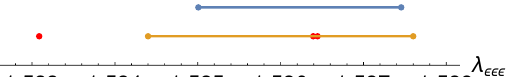
Figure 2 . In blue: rigorous bounds on λ (cid:15)(cid:15)(cid:15) 0 found at Λ = 19 using algorithm 2. In or- ange: the interval corresponding to one standard deviations of the values found for λ ing the extremal functional as found in [4] at Λ = 43 . The red dots indicate the